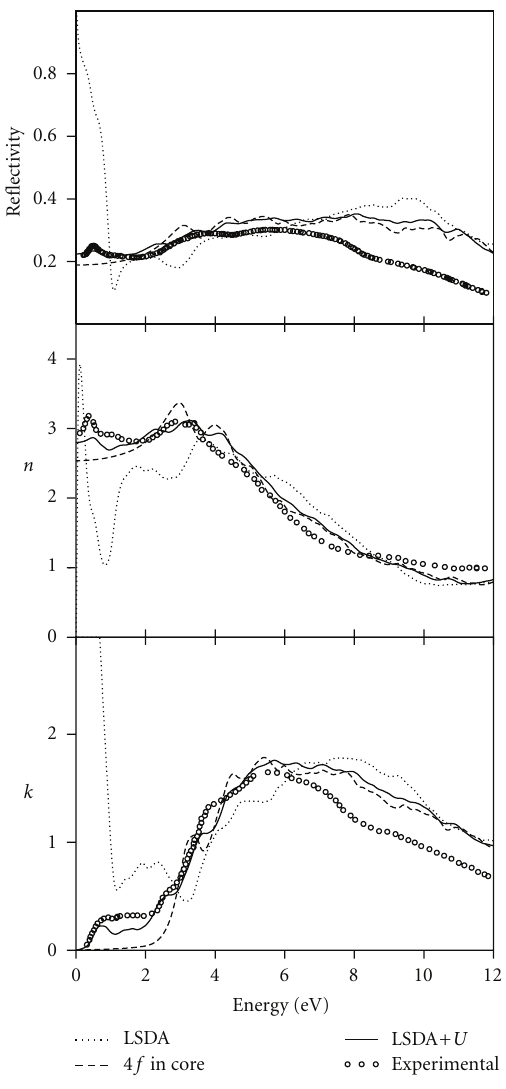
Figure 90: Calculated [455] optical reflectivity R , real refractive index n , and extinction coe ffi cient k of Sm 3 S 4 treating 4 f states as (1) fully localized (4 f in core) (dashed line), (2) itinerant (dotted line), and (3) partly localized (LSDA+ U approximation) (solid line) compared with experimental data (open circles) [439].